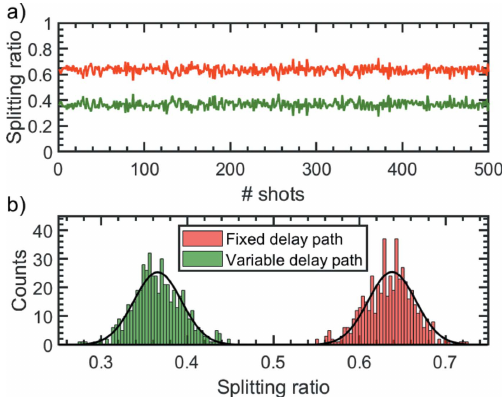
Figure 6 ( a ) Measured splitting ratio variations for an average splitting ratio of 63:37 over 500 shots, taken at a rate of 1 Hz. ( b ) Splitting ratio variation of both partial beams. The splitting ratio variation amounts to (cid:4) 0.033 (FWHM) and 0.029 (r.m.s.), respectively.